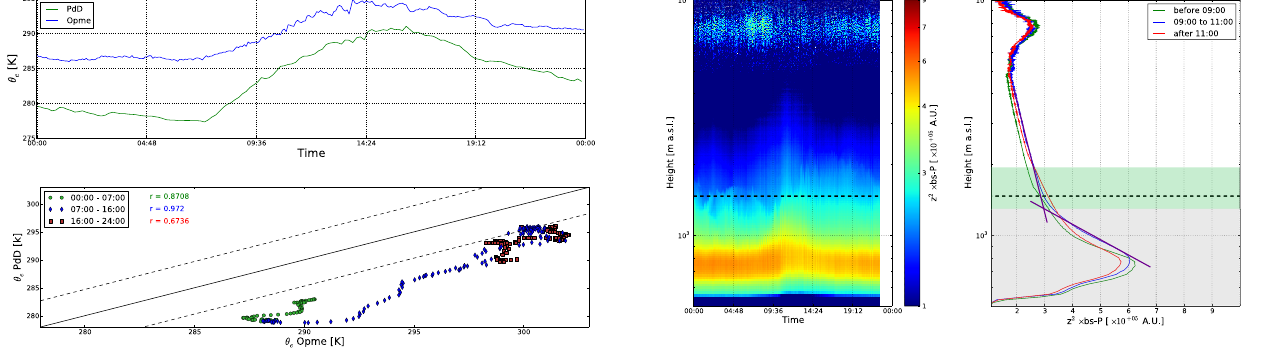
Fig. 11. Temporal evolution of equivalent potential temperature at both sites during a simultaneous nucleation event (“D S ”, 22 March 2009).